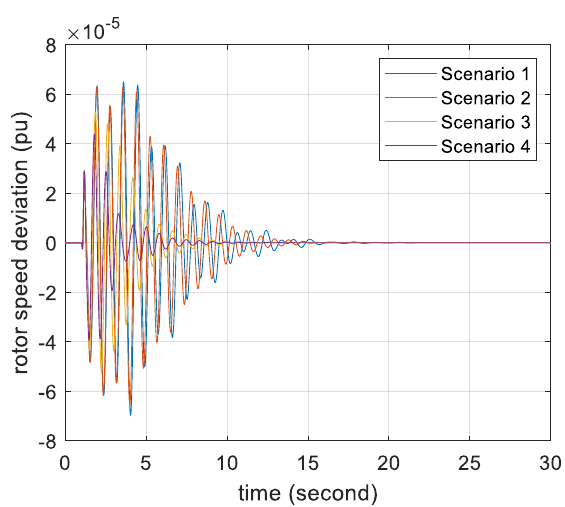
Figure 11. Rotor speed responses of G4.